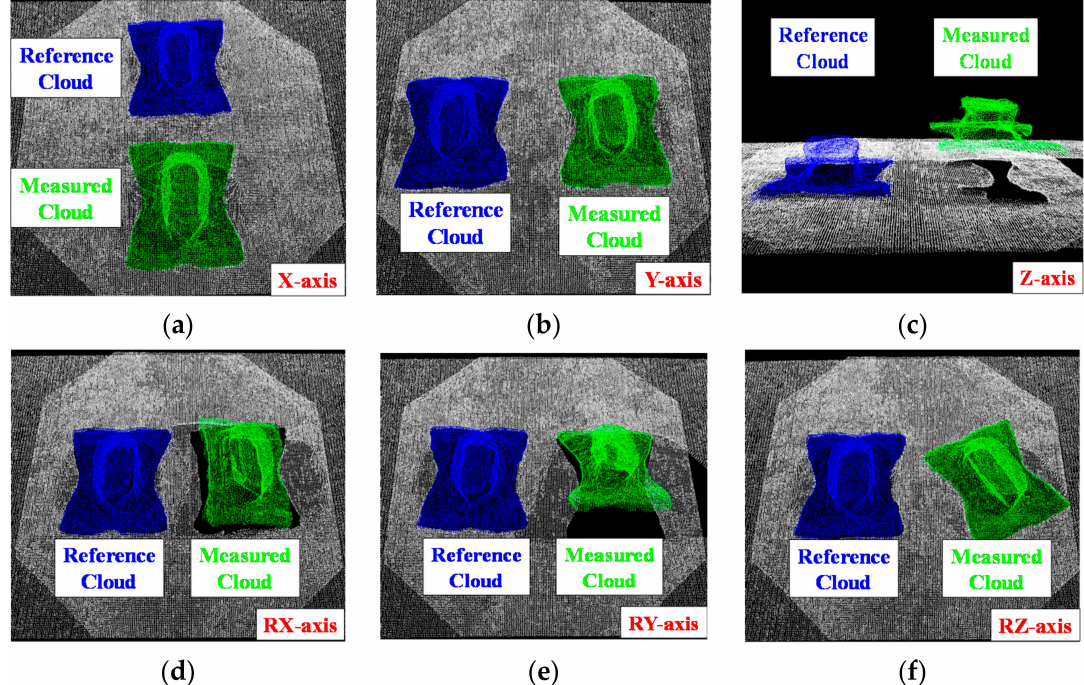
Figure 10. Building reference point cloud models of each 6-DoF pose for estimating measured clouds of the dynamic workpiece in the ( a ) i-axis, ( b ) Y -axis, ( c ) Z -axis, ( d ) RX -axis, ( e ) RY -axis, and ( f ) RZ